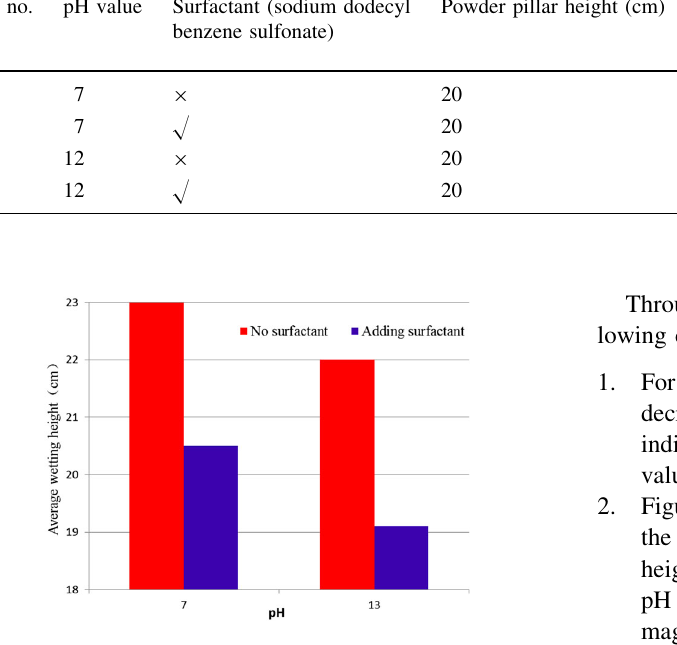
Fig. 4 Pulverized coal’s average wetting height in different solutions